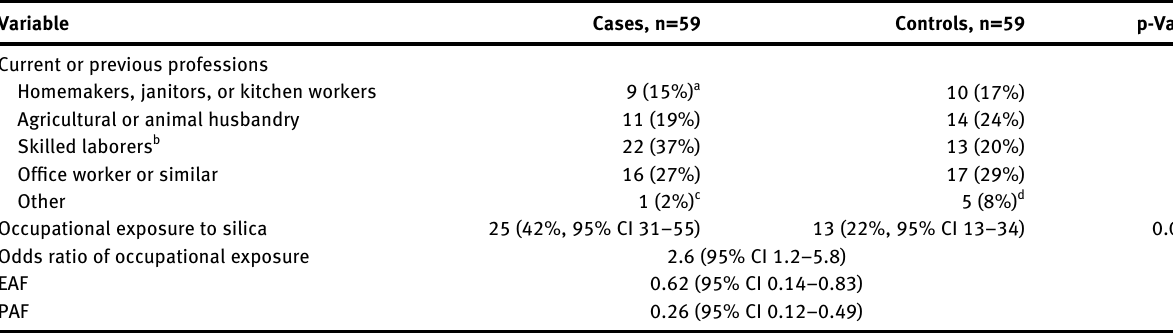
Table  : Occupational groups among cases and controls.